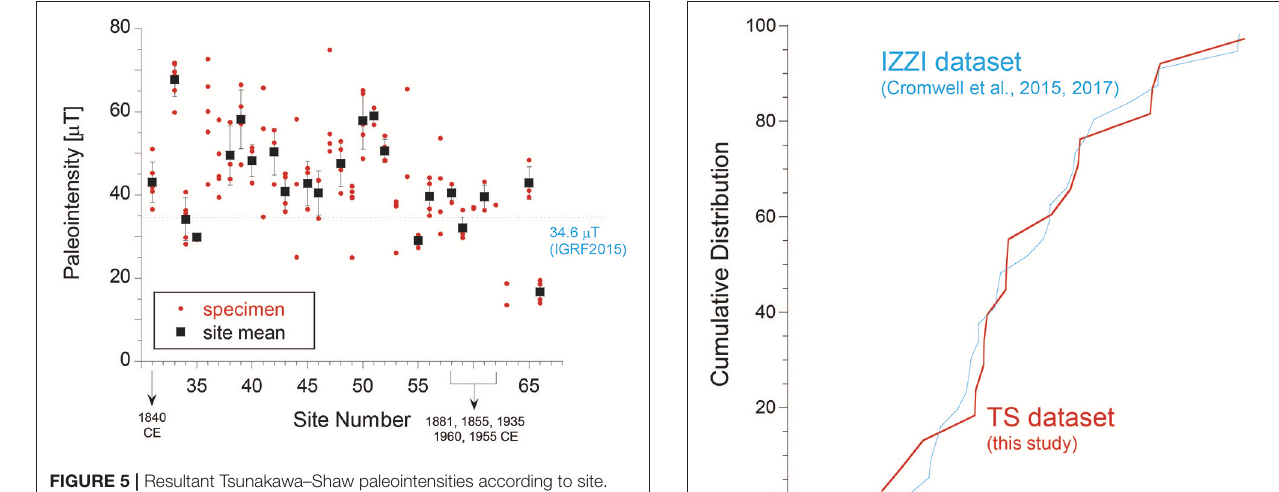
FIGURE 5 | Resultant Tsunakawa–Shaw paleointensities according to site. Individual specimen-level paleointensities are indicated by red circles for all sites. Site-mean paleointensities are also shown by black squares with their one standard deviation (1 σ ) if they were yielded from more than three individual specimens ( N ≥ 3) and the associated standard deviation was < 15% of the site mean ( σ ≤ 15%).